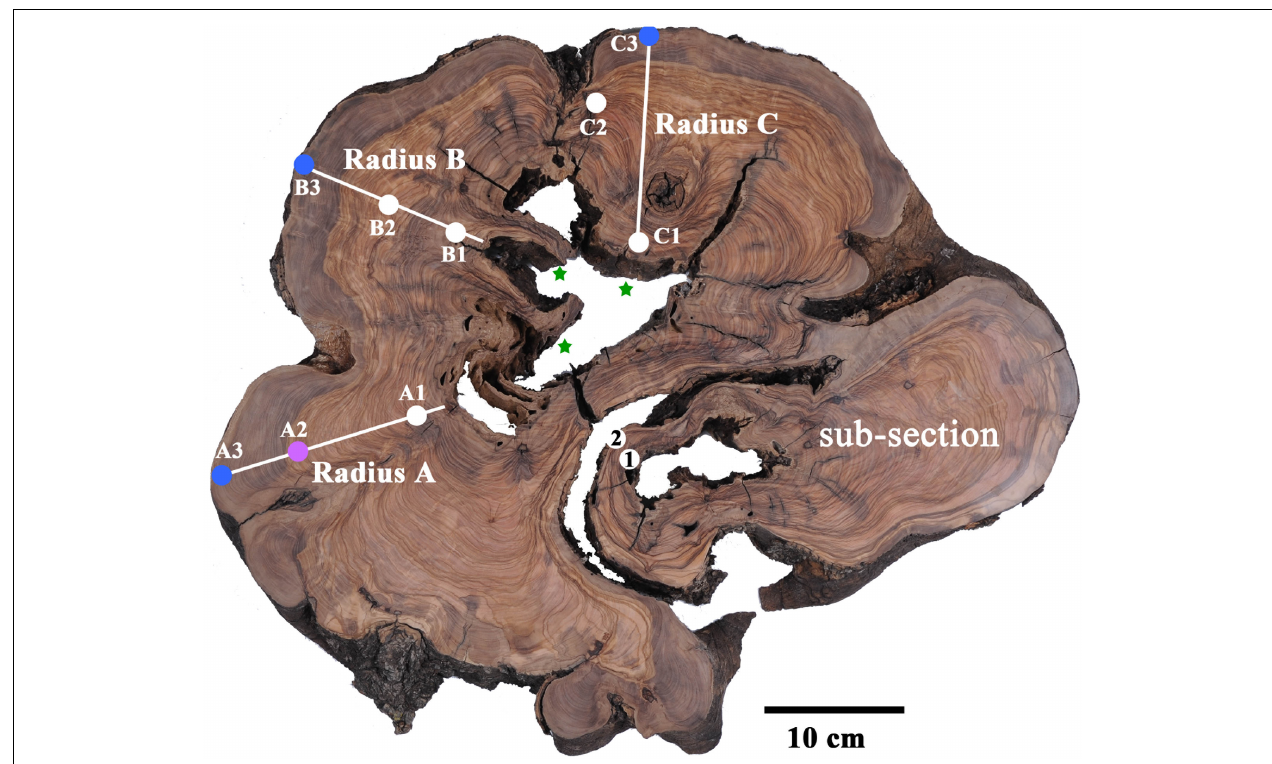
FIGURE 2 | Transverse section of olive tree trunk, cut down in 2013, several years after the tree had died. Sampling points marked on cross-section, color coded to pre-1955 (white); 1970–1979 (magenta); 2000–2009 (blue). Stars mark the presumed location of original piths. Note the bottom right nearly separate sub-section, which was found to be younger than the points A1, B1 and C1, and was therefore not considered in tree age